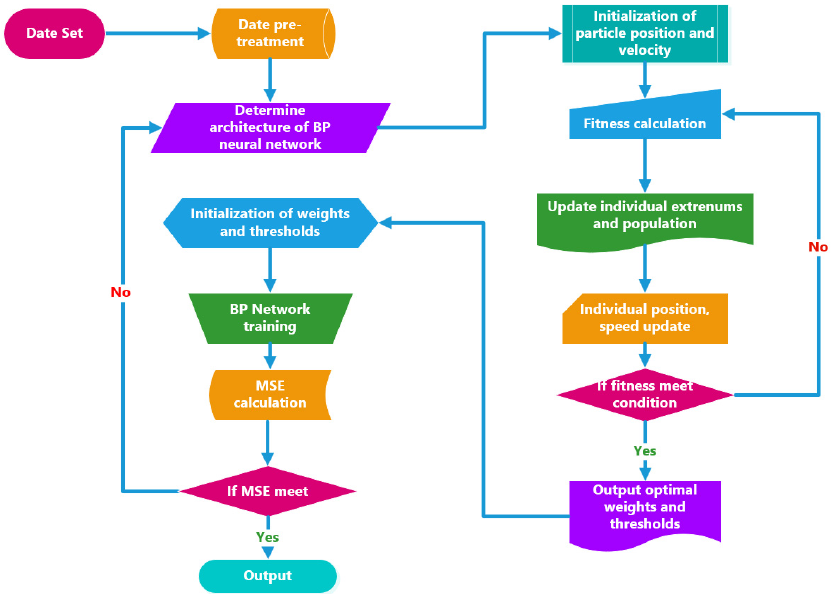
Figure 3. A simple scheme for BP optimization through the PSO